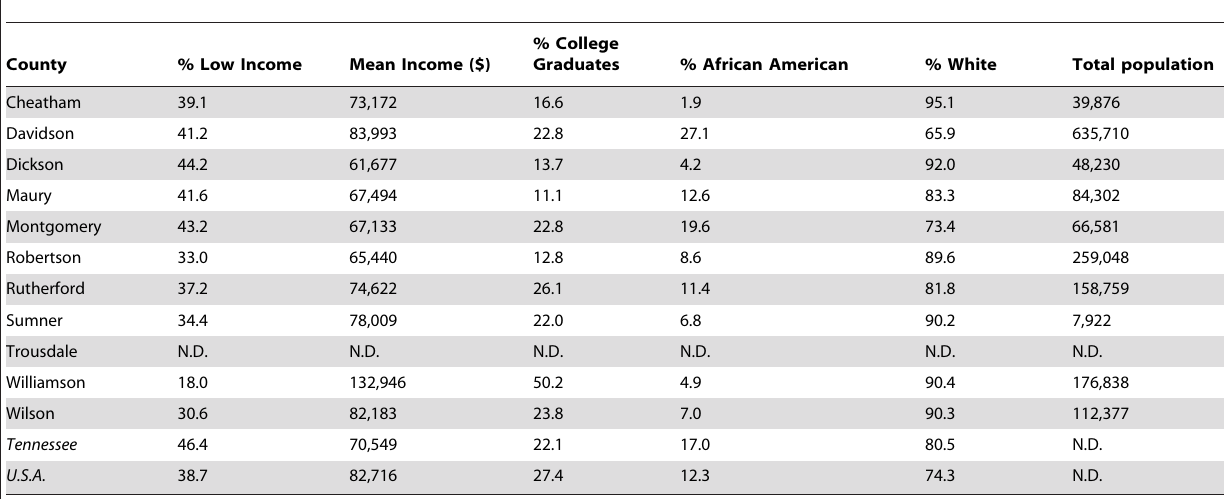
Table 1. Sociodemographic characteristic of the Middle Tennessee Community Profile Analysis.